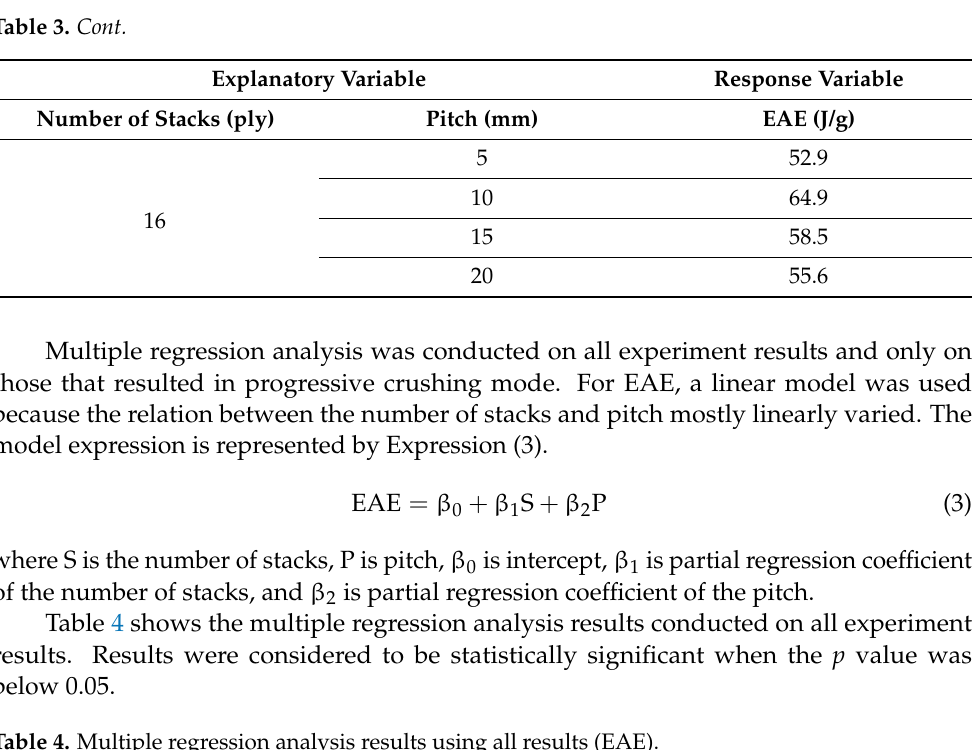
Table 4. Multiple regression analysis results using all results (EAE).